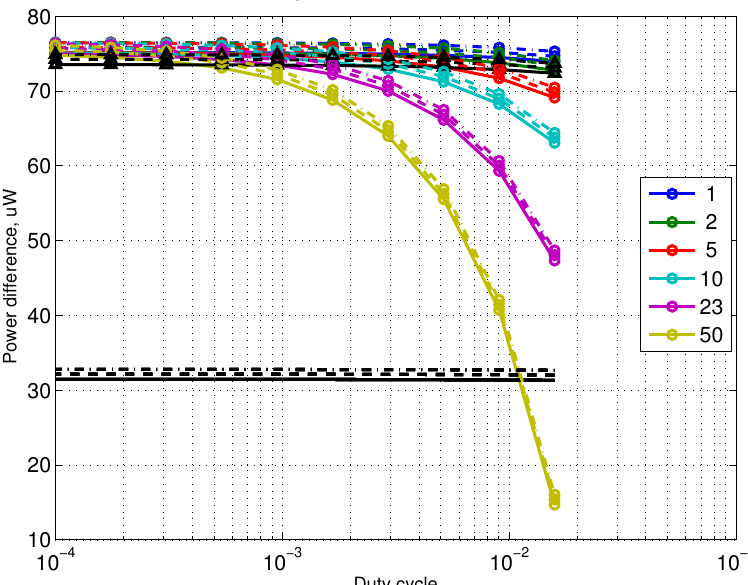
Figure 10. When M t = 1 and M r = 1, power difference while operating. Capacitor ( C s = 0.35 F). Non-WuR in black (without triangles), passive WuR in colors indicating number of nodes for different host duty cycles per node ( β (cid:48) w ). Semi-passive WuR in black with triangles. Line type indicates used SC